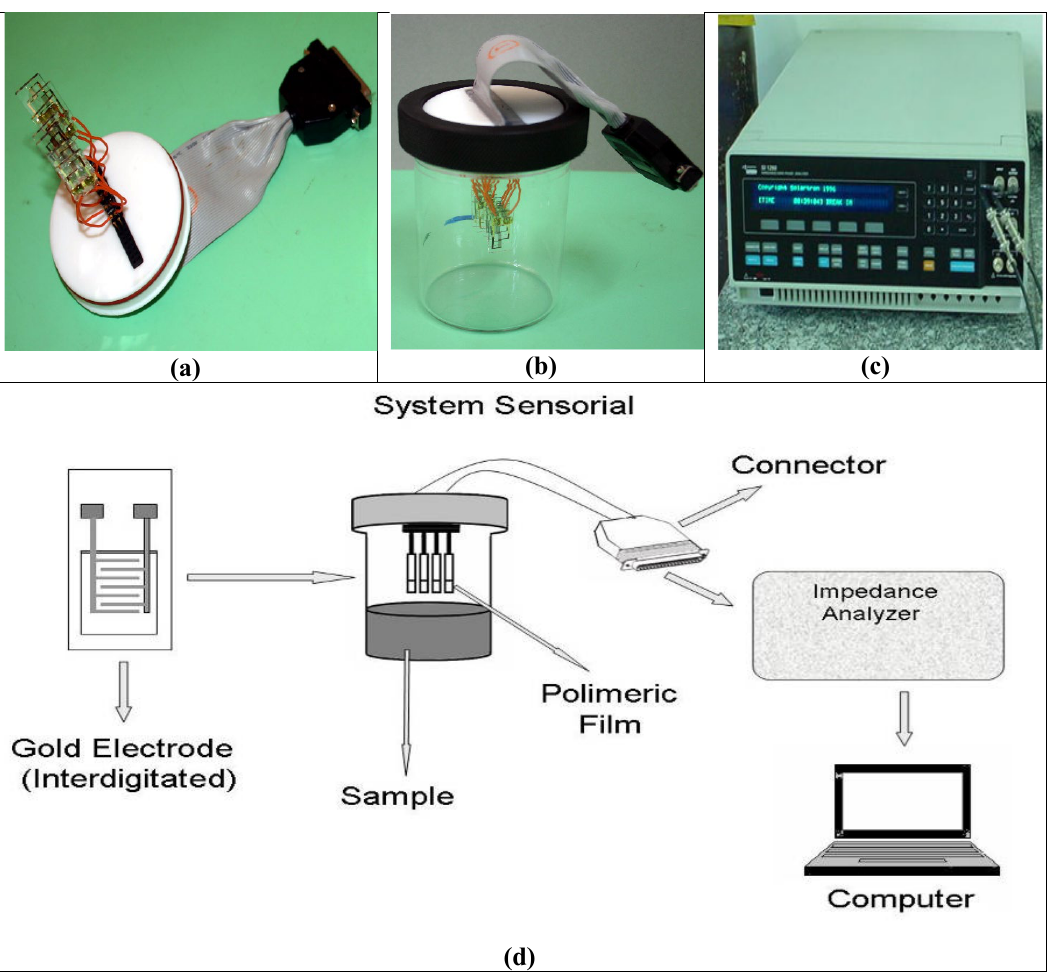
Fig. 2. (a) Microelectrode; (b) Sensory system assembled with the different deposited nanostructured polymers and he sample holder; (c) Solartron impedance analyzer SI 1260 and (d) Data acquisition scheme.Font.: